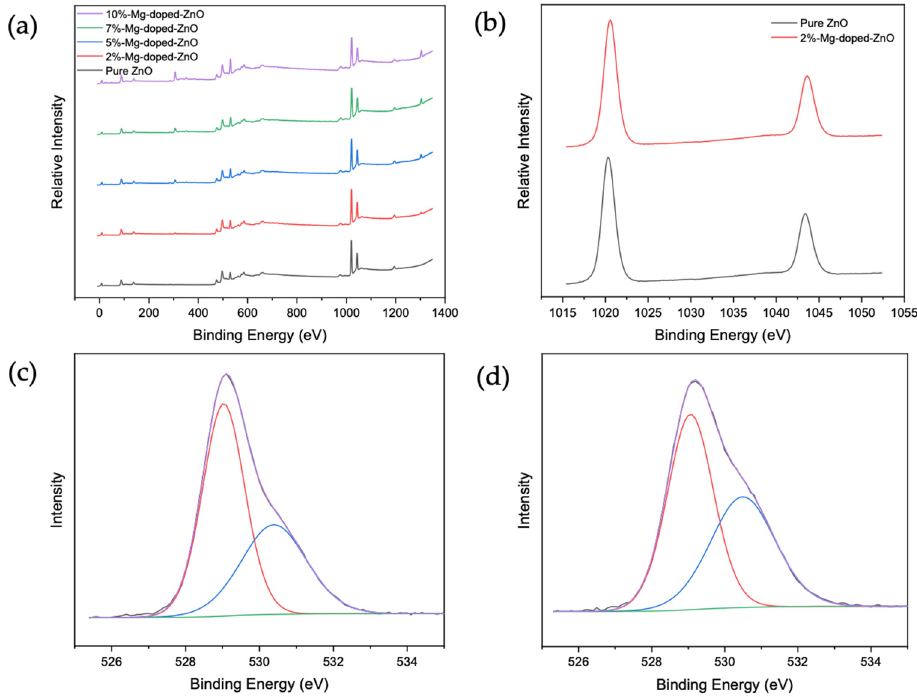
Figure 2. ( a ) XPS full scan of pure and Mg-doped ZnO nanoparticles; ( b ) high-resolution Zn scan of pure ZnO and 2% Mg-doped ZnO nanoparticles; ( c ) high-resolution O1s scan of pure ZnO nanoparticles; ( d ) high-resolution O1s scan of 2% Mg-doped ZnO nanoparticles.